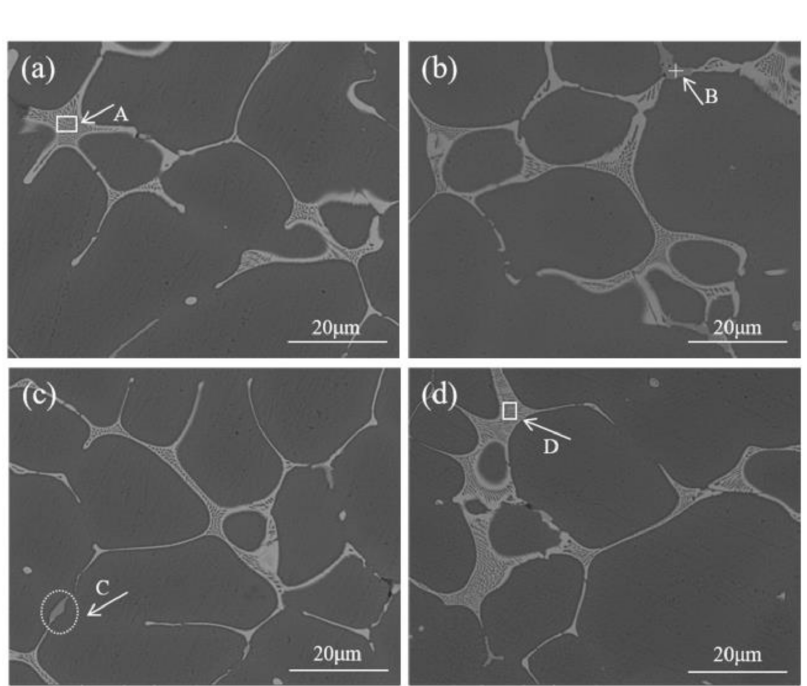
Figure 8. BSE images of UT-SC sample alloy with different Zr content: ( a ) Alloy A; ( b ) alloy B; ( c ) alloy C; ( d ) alloy D.